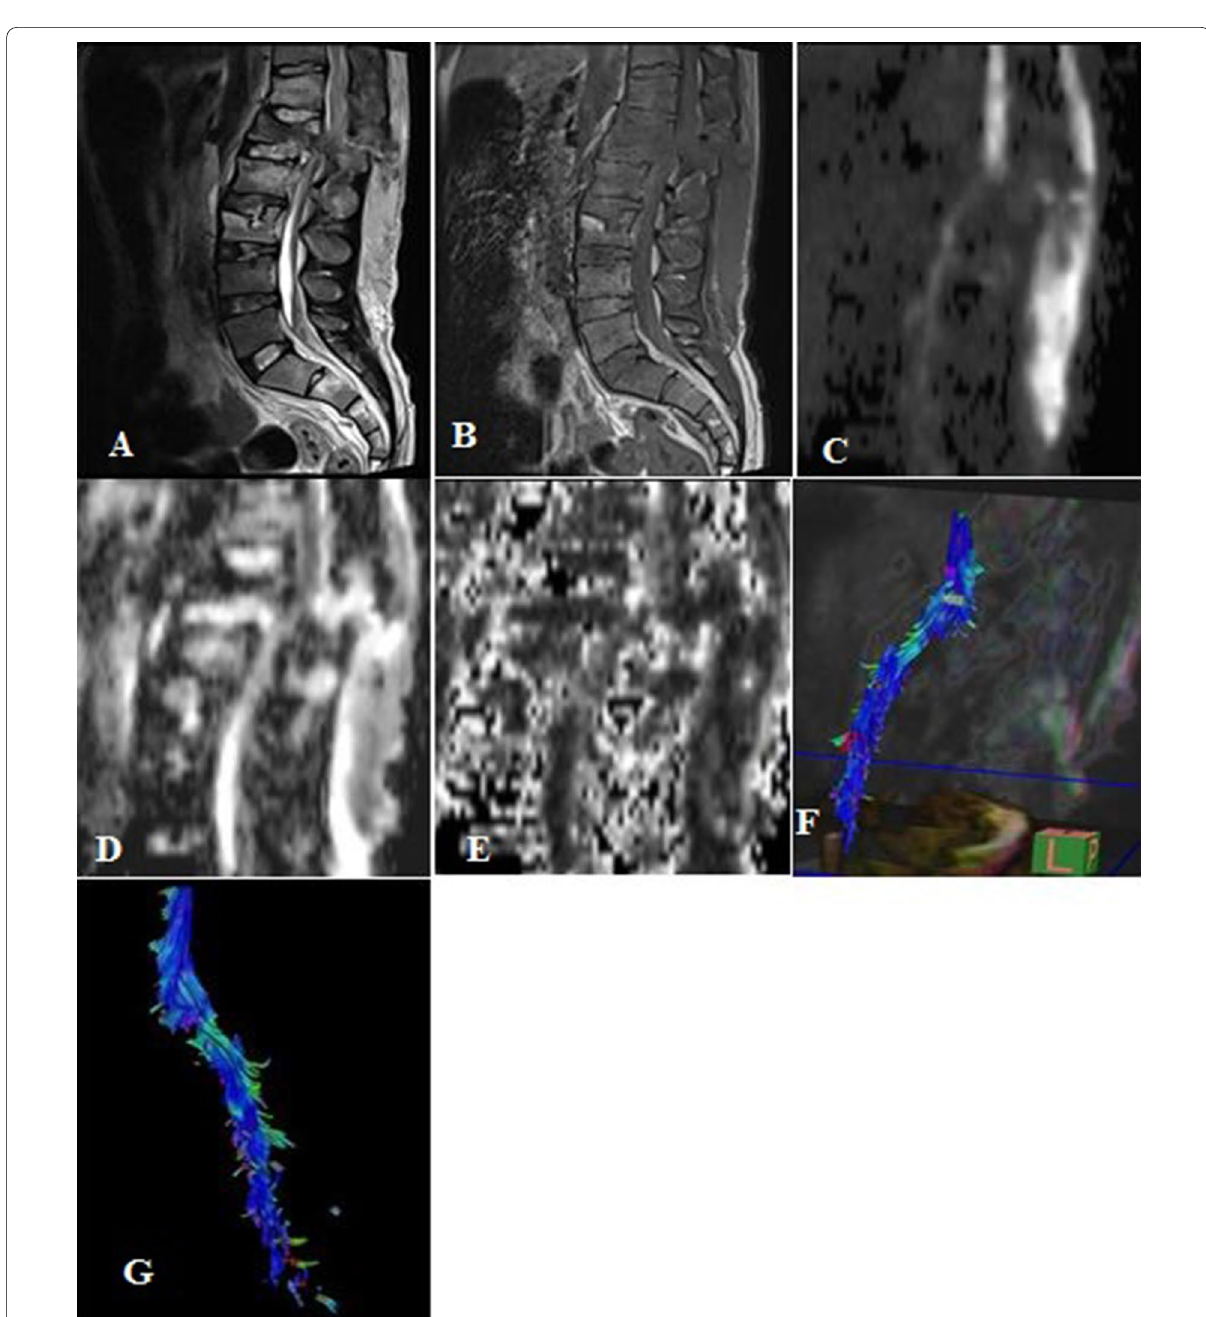
Fig. 1 A 31‑year‑old male patient, fall from height ‘palm tree’ presented with paraplegia and incontinence. Sagittal T2‑weighted ( A ) and T1‑weighted ( B ) images show compression fracture of L1 vertebral body with posterior retropulsion and posterior paraspinal soft tissue injury including flava, interspinous and supraspinatus ligaments. Large amount of cord edema with high T2 signal intensity and no appreciated T1 signal abnormality. Sagittal trace ( C ), ADC ( D ) and grayscale FA ( E ) images show high trace signal intensity with corresponding low ADC value and low FA signal intensities within the compressed part of the spinal cord. 3D MR fiber tractography images ( F , G ) show partial fiber disruption on the posterior aspect of the contused spinal